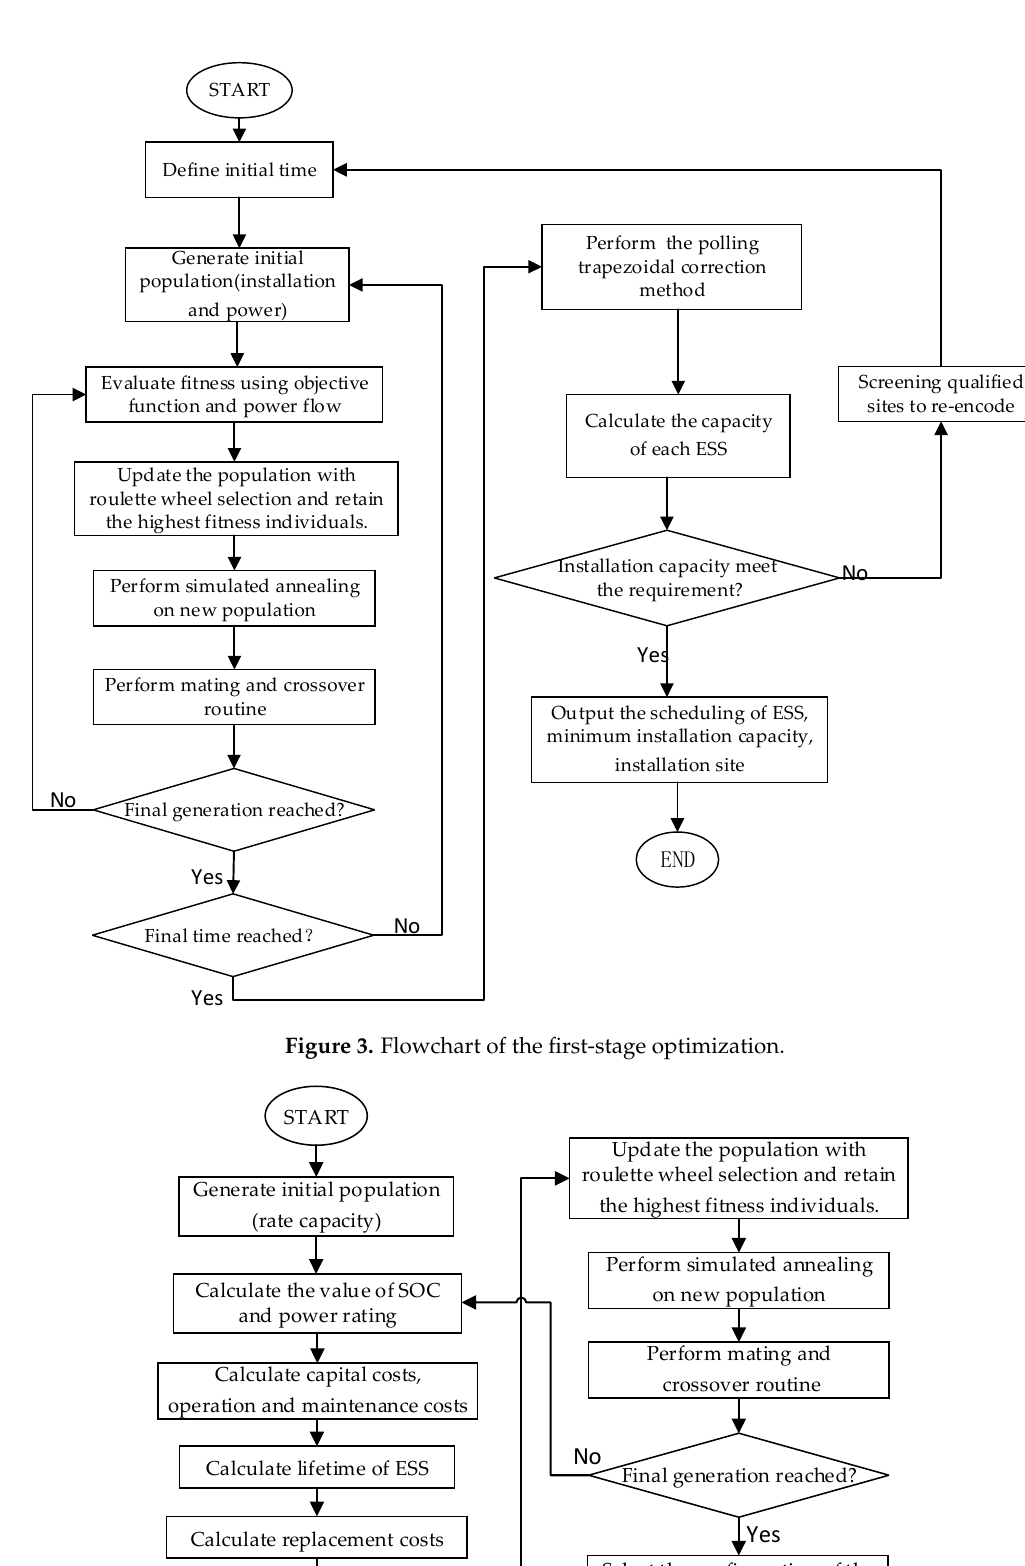
Figure 4. Flowchart of the second-stage optimization.